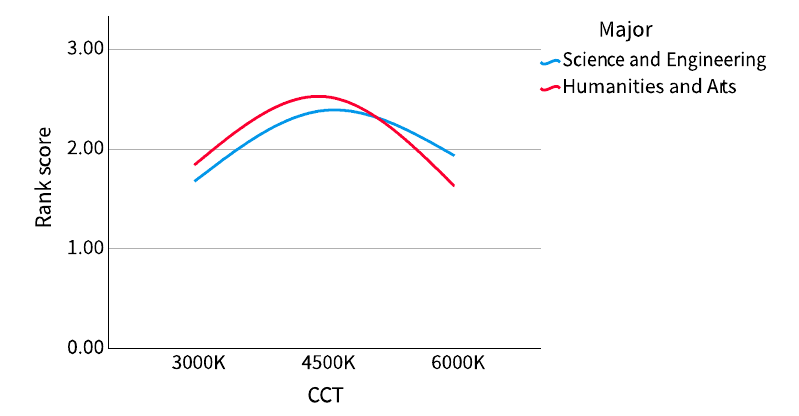
Figure 12. Preference ranking (sex).